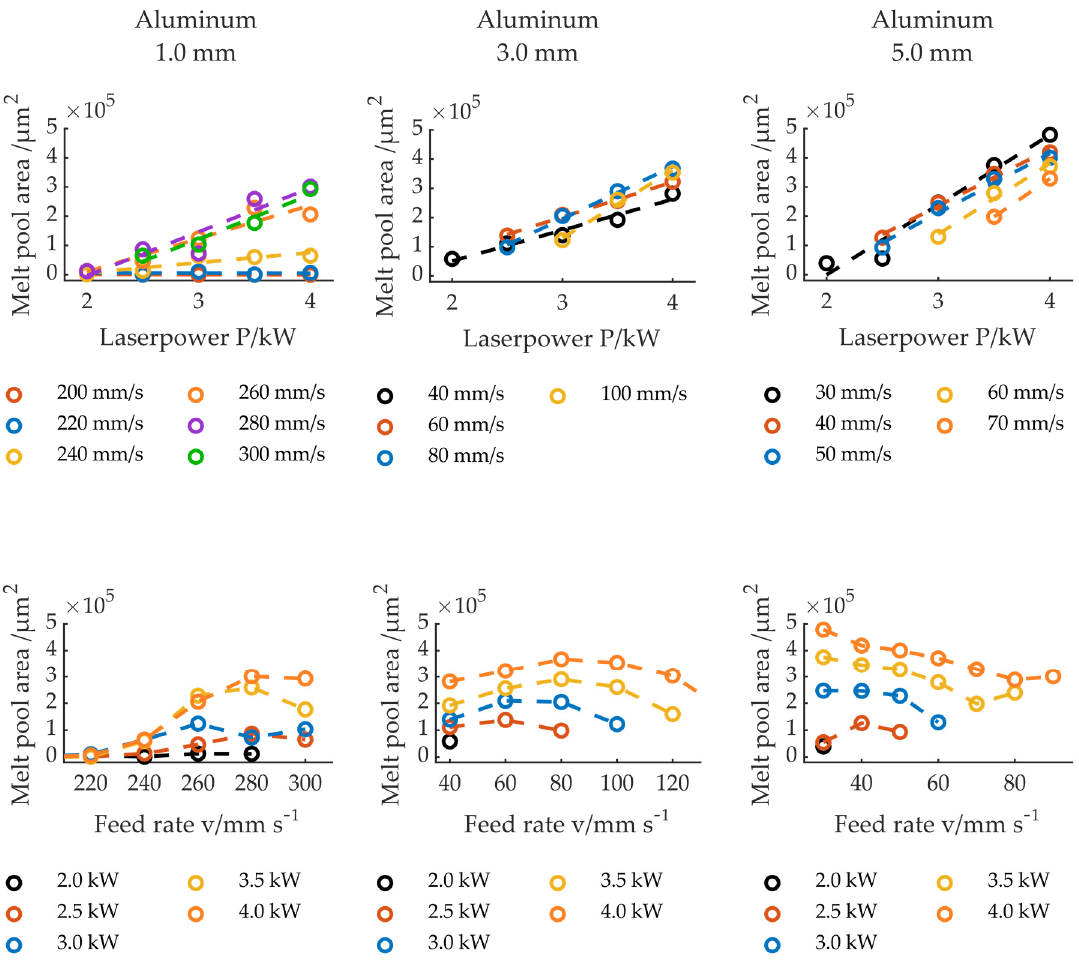
Figure 8. Average size of the melt pool area depends on the laser power and feed rate for 1.0, 3.0, and 5.0 mm thick aluminum.